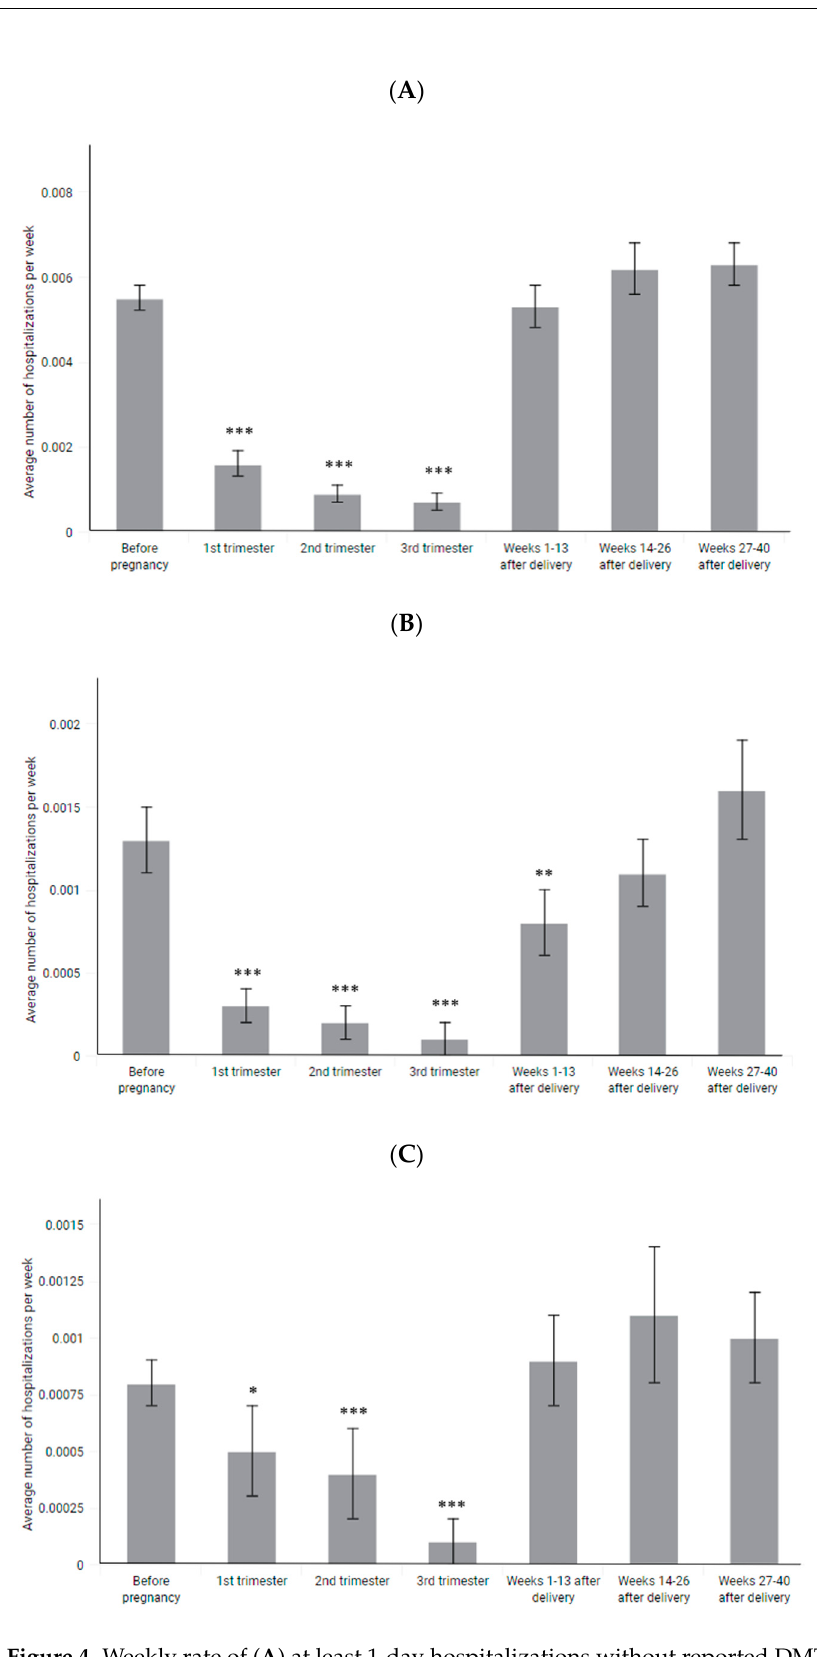
Figure 4. Weekly rate of ( A ) at least 1-day hospitalizations without reported DMT products, ( B ) at least 1-day hospitalizations reported with steroid injection procedure, ( C ) emergency department visits, expressed as means with SEM. *– p -value < 0.05, **– p -value < 0.01, ***– p -value < 0.001.